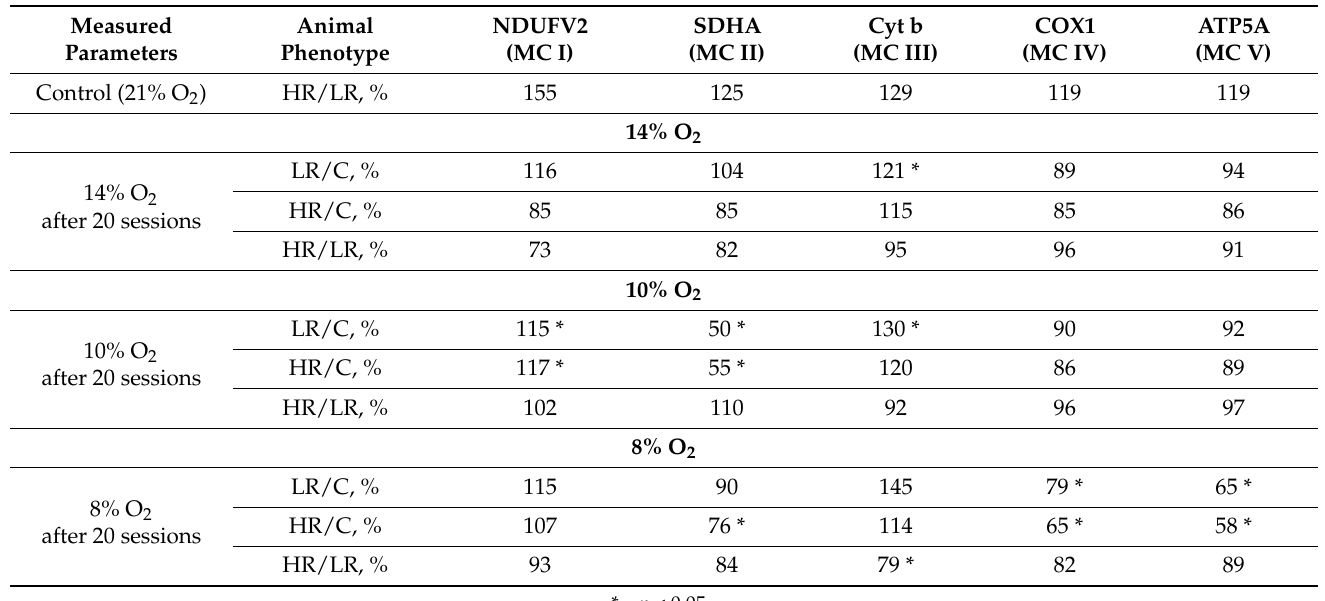
Table 1. Contents of mitochondrial enzyme catalytic subunits (MC I-IV) in cerebral cortex (CC) of high-resistance (HR) and low-resistance (LR) rats (in % of control) in normoxia and following 20 sessions of one-hour hypoxic exposure in three different regimens.